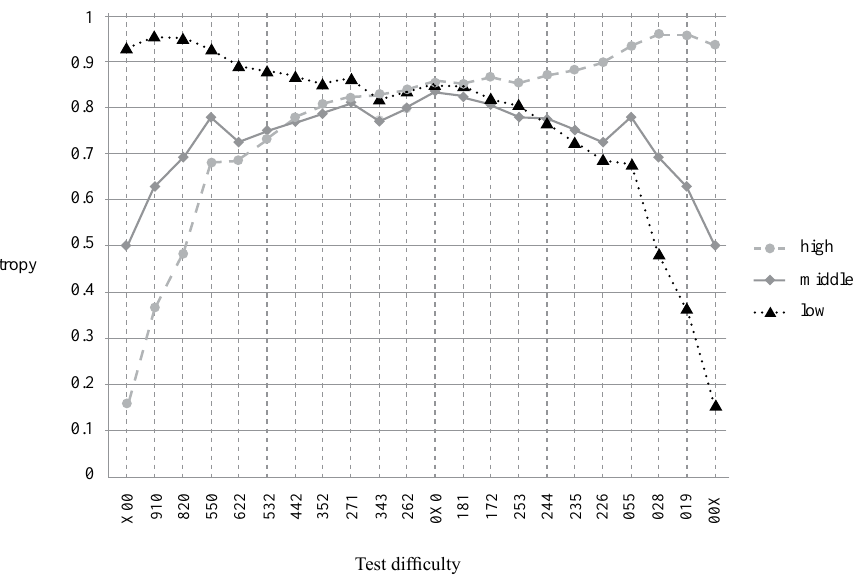
Fig. 5. Entropy functions for 10 items tests for the populations of low, middle and high attainment level